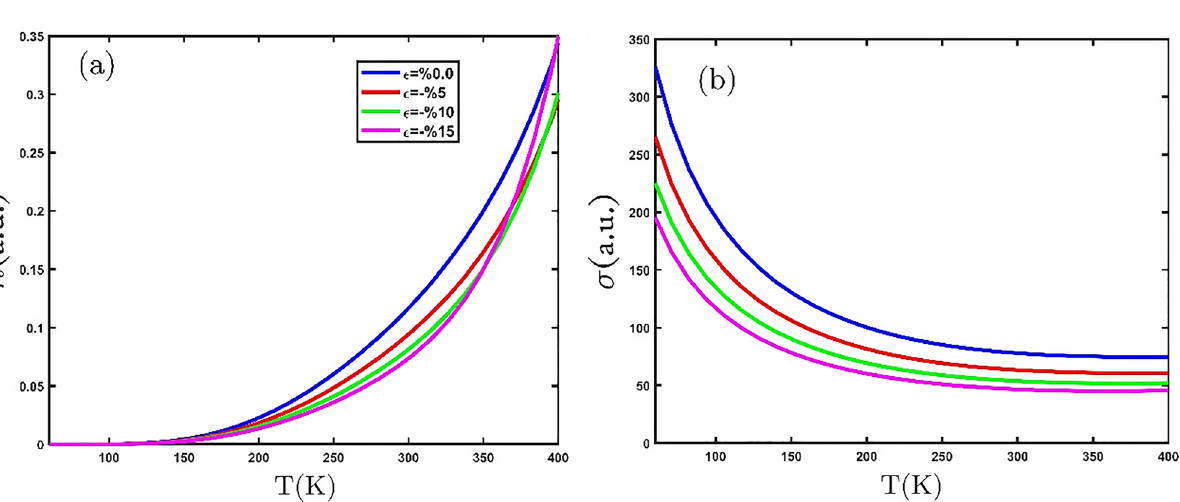
Figure 10. ( a ) The electrical thermal conductivity and ( b ) electrical conductivity as a function of temperature, for several compressive biaxial